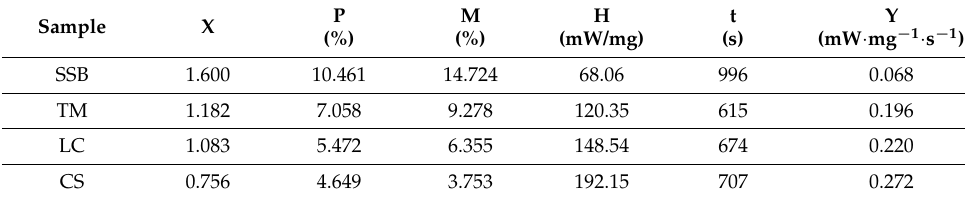
Table 4. Microstructure parameters and pyrolysis parameters of four